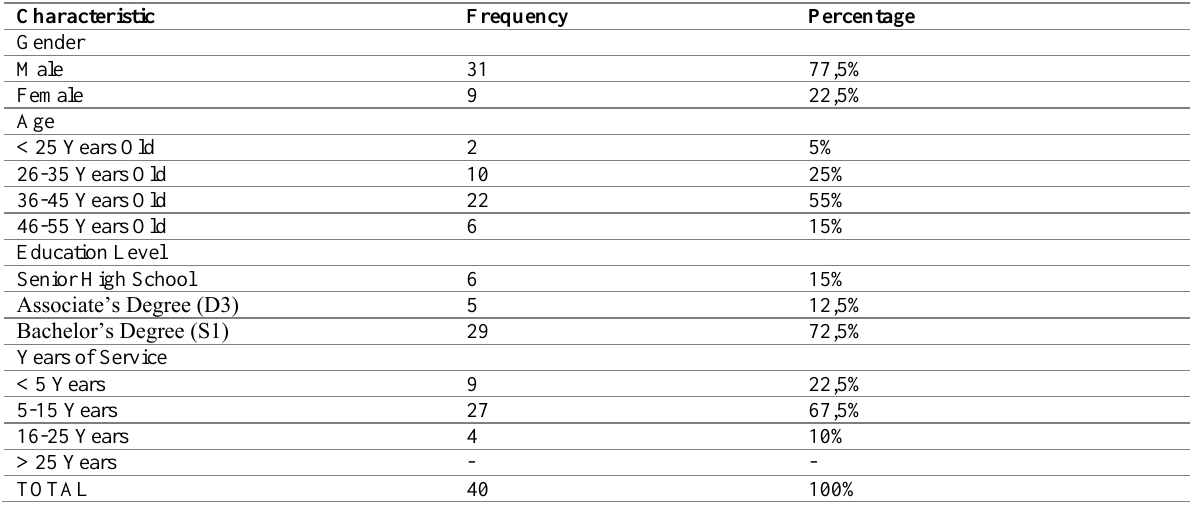
Table 1: Respondent’s